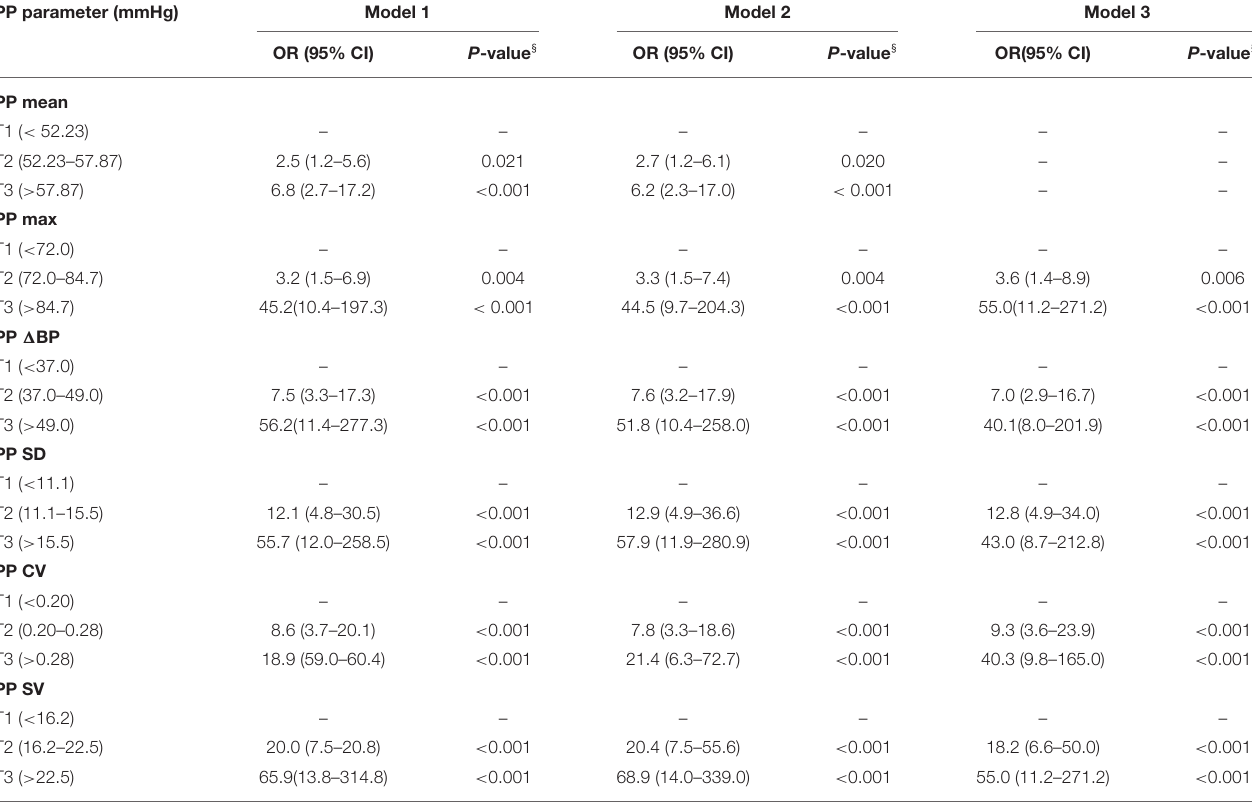
TABLE 4 | OR for poor outcome at at 3-months according to the tertile of PP variability